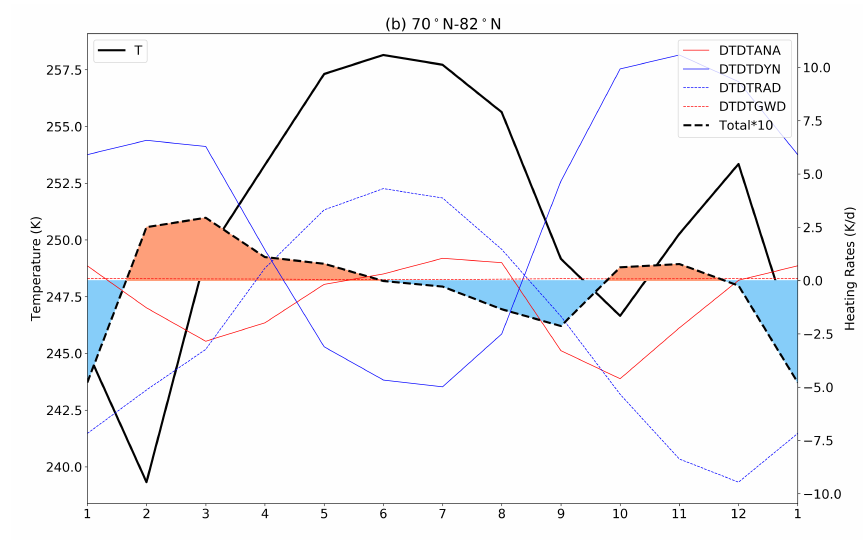
Figure 6. Annual cycle of the zonal mean temperature and heating rates at 0.3 hPa averaged around the SH high latitudes (58 ◦ S–70 ◦ S) ( a ) and NH high latitudes (70 ◦ N–82 ◦ N) ( b ) based on MERRA2 data. The red, blue, dashed blue and dashed red lines indicate the heating rates related to analysis tendency (DTDTANA), dynamics (DTDTDYN), radiation (DTDTRAD) and gravity wave drag (DTDTGWD), respectively. The positive total heating rates are filled with orange color and the negative total heating rates with blue color. The total heating rates, which are the sum of analysis, dynamical, radiative and GWD heating rates, have been enlarged 10 times to be more visible in the